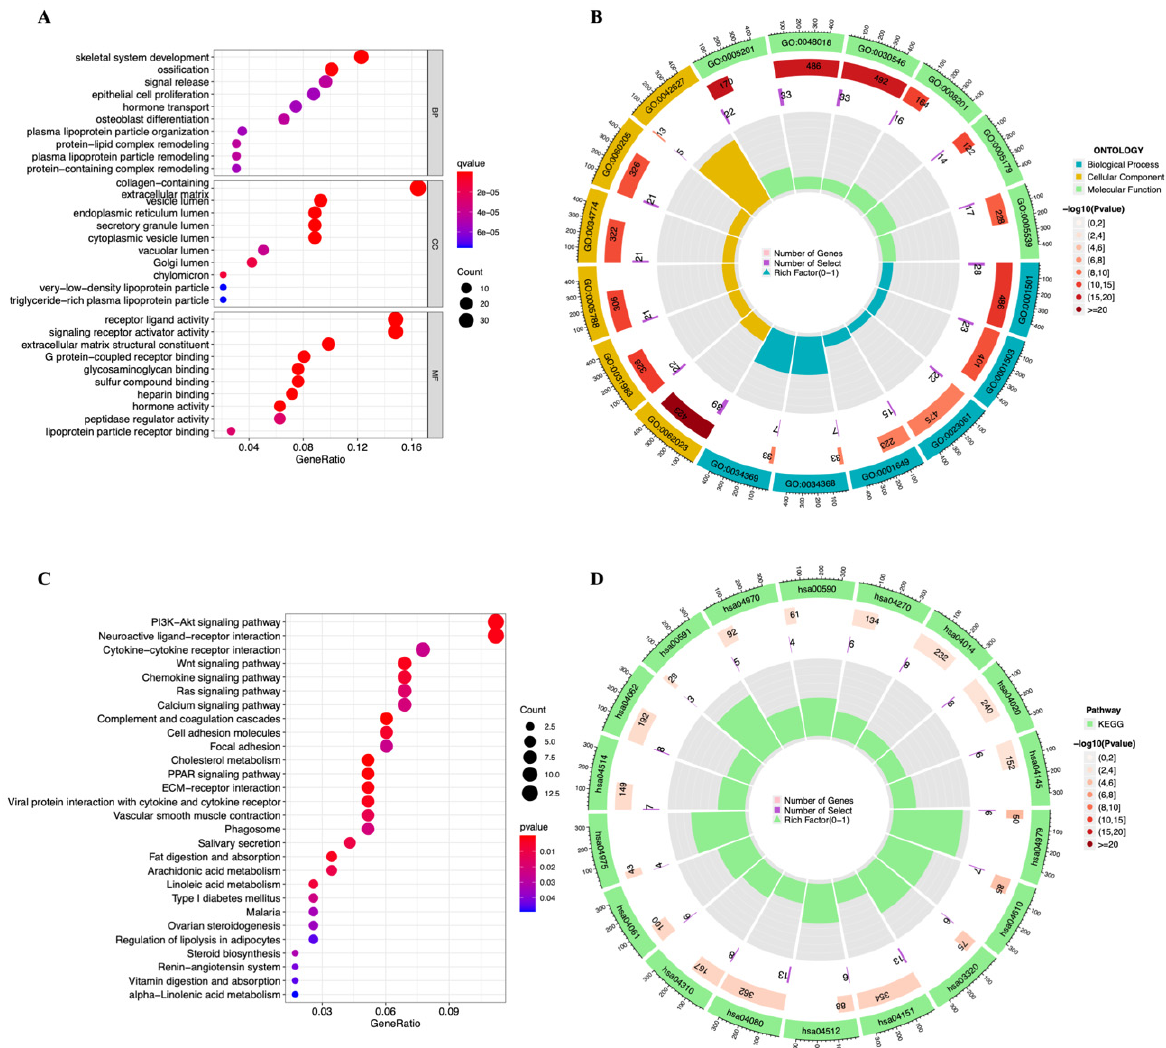
Figure 8. GO and KEGG analysis. ( A , B ) Gene ontology (GO) analysis demonstrated the richness of molecular biological processes (BP), cellular components (CC), and molecular functions (MF). ( C , D ) KEGG pathway analysis showed significantly enriched pathways.